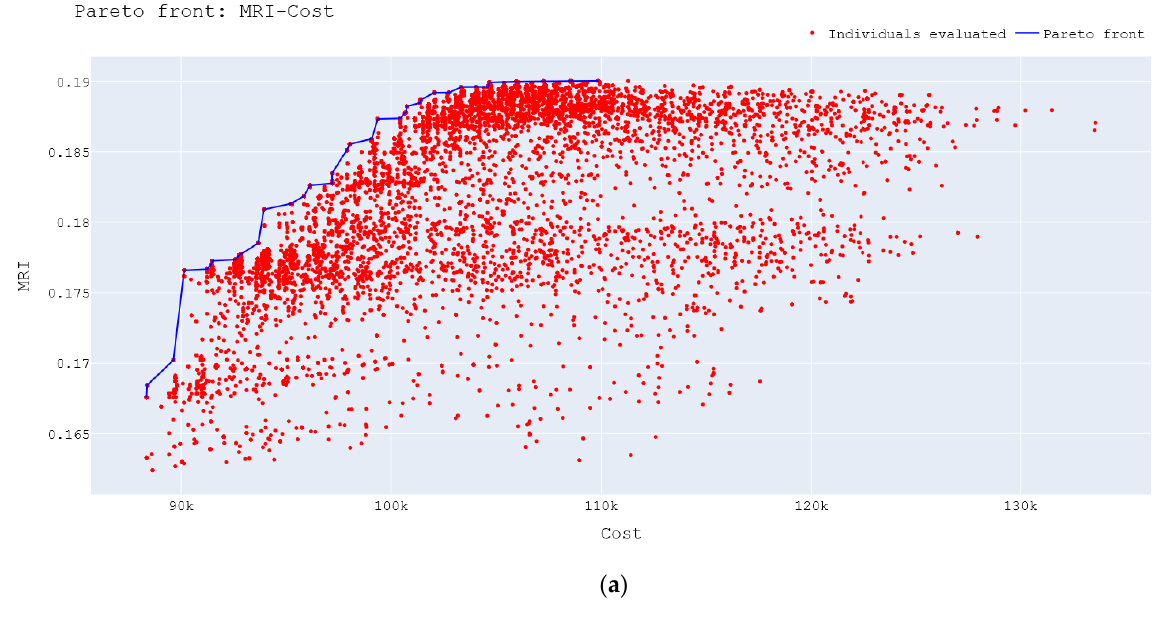
Figure 6. MRI and investing cost values of the single-objective function.